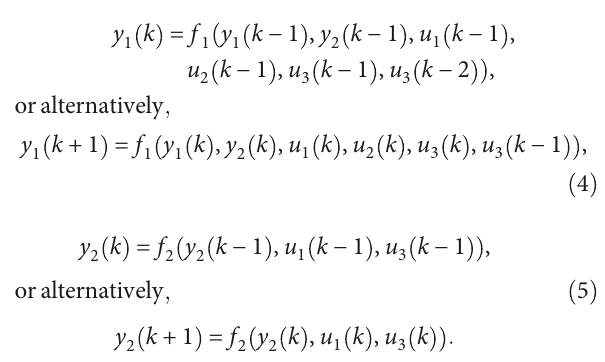
Table 6: Cluster centers for substrate y